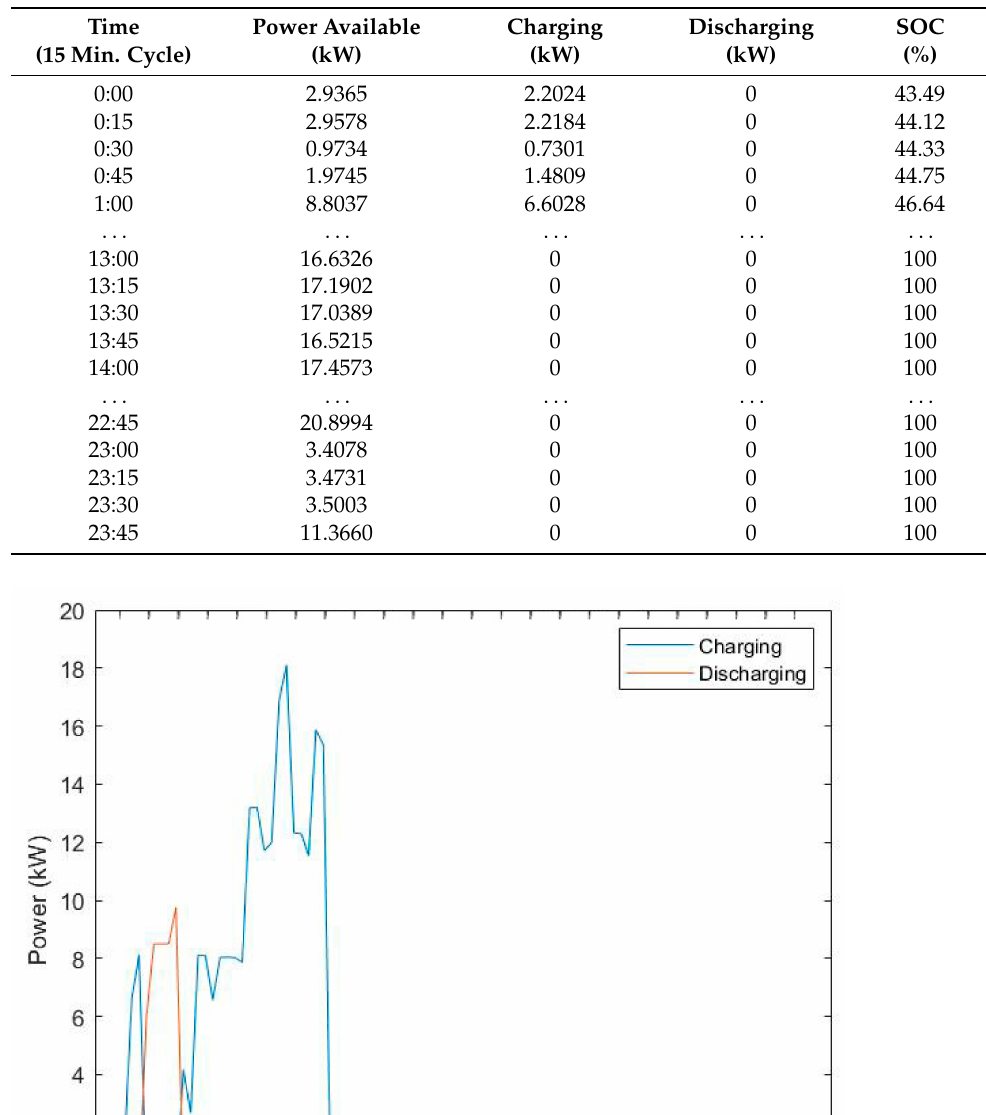
Table 6. Power available, Charging, Discharging, and SOC values in Normal Grid. Time Power Available Charging Discharging